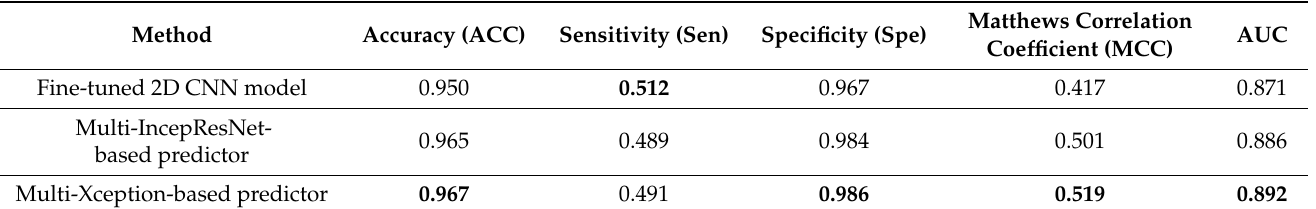
Table 4. Prediction performance of multi-IncepResNet-based predictor, multi-Xception-based predictor, and the fine-tuned 2D CNN model on ATP-388 over five-fold cross-validations (The highest value of each column in the table is shown in bold).